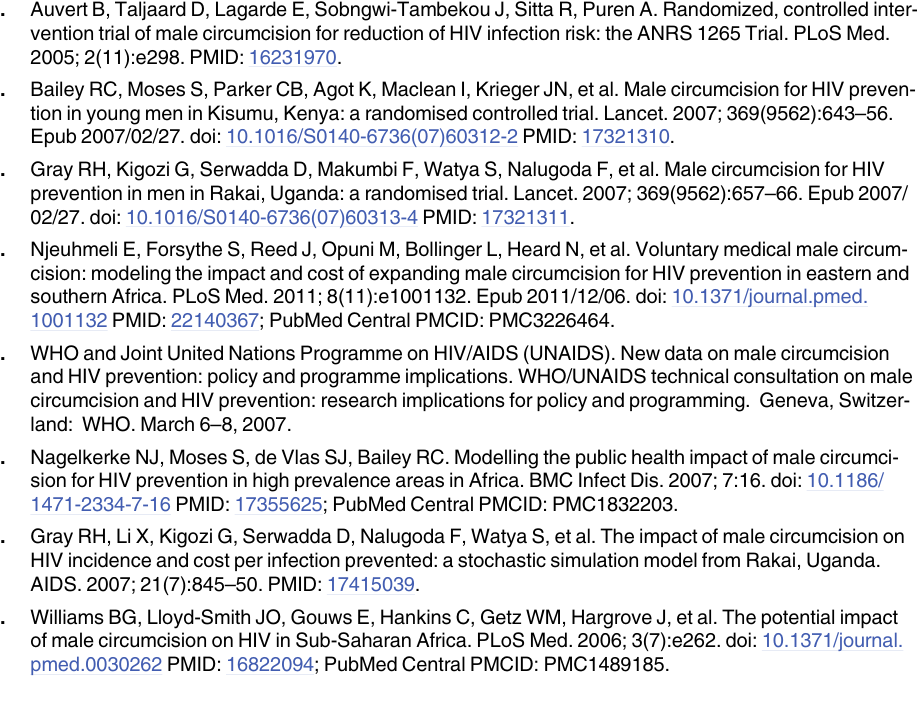
S4 Table. Epidemic impact of prioritizing different geographic locations in the voluntary medical male circumcision (VMMC) program. S5 Table. Epidemic impact of prioritizing different risk groups in the voluntary medical male circumcision (VMMC)